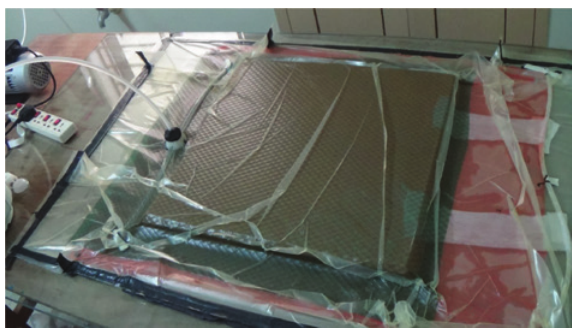
Figure 4: Fabrication of PFHS panel by vacuum infusion process.